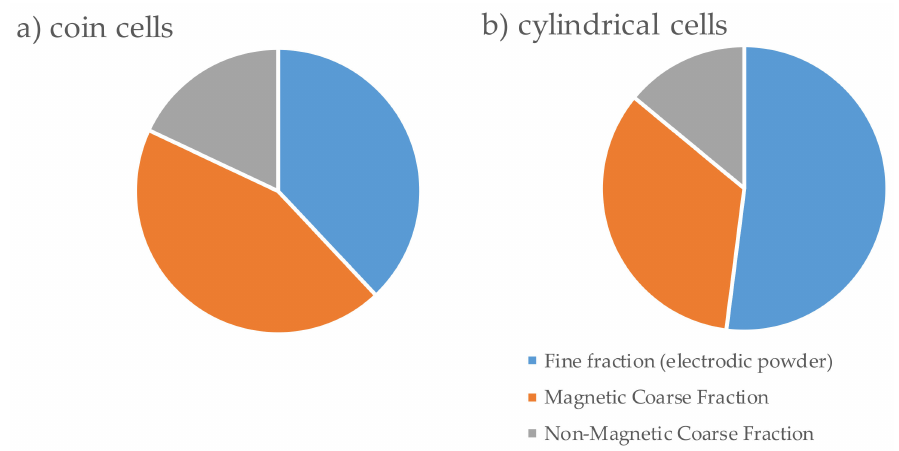
Figure 5. Pie chart for distribution of di ff erent waste fractions from cryo-mechanical treatment and separation (sieving and magnetic separation) for coin (subfigure ( a )) and cylindrical cells (subfigure ( b